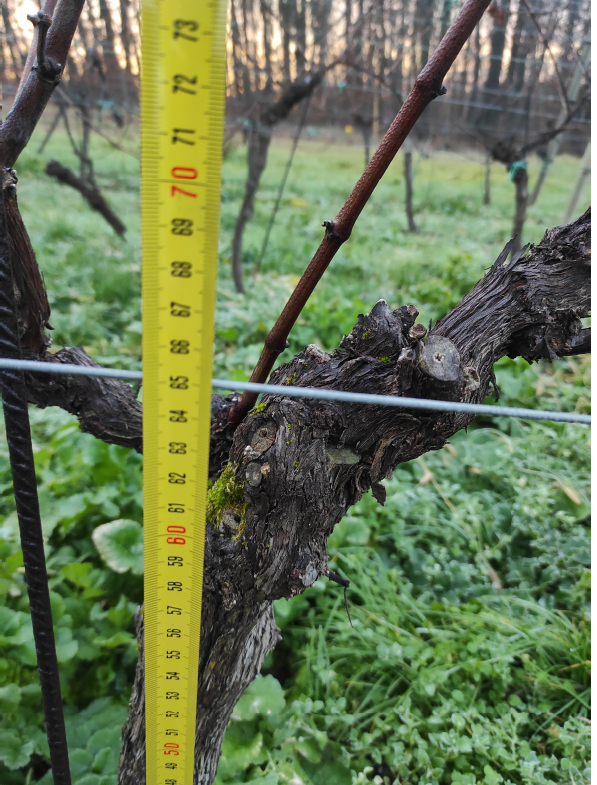
Figure 11. A section of the vine where the trunk of the vine begins to divide into two stems. The fork is located in the vineyards at the level of the first wire. In this case (vineyard Jazbina), it is located at a height of 65 cm above the ground.